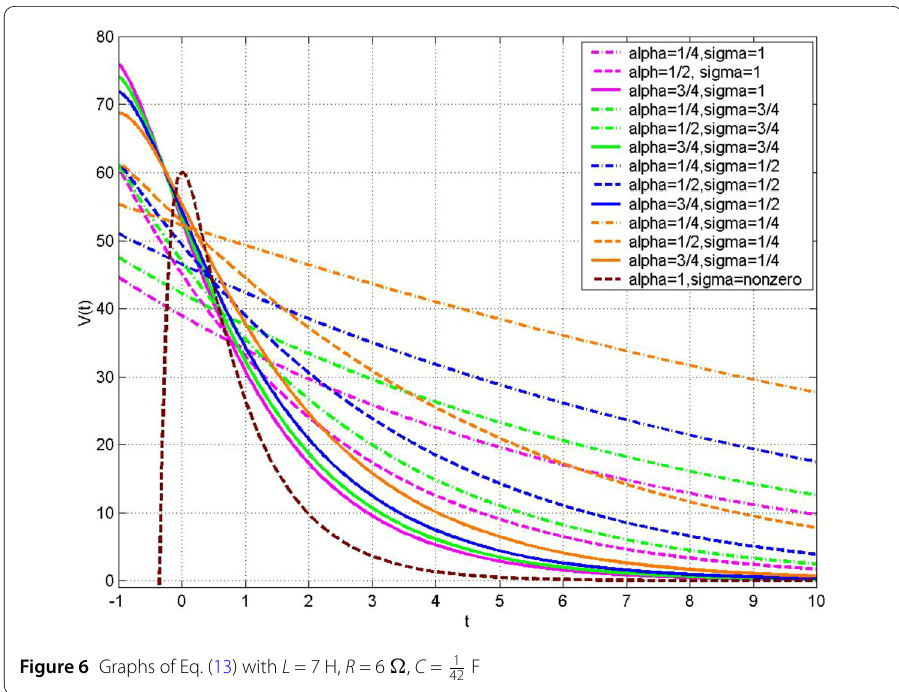
Figure 6 Graphs of Eq. (13) with L = 7 H, R = 6 (cid:4) , C = 1